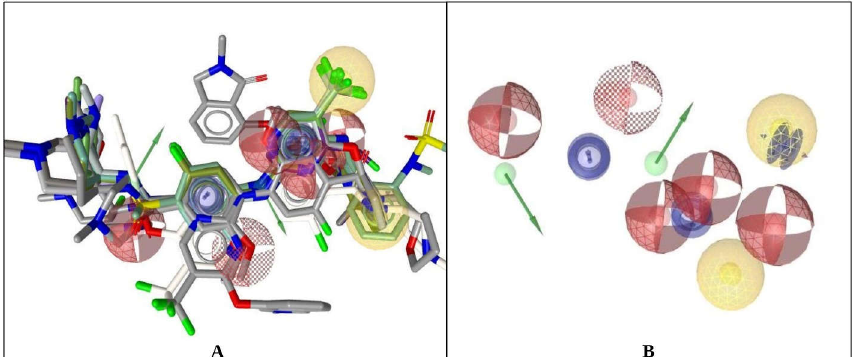
Figure 1. The 3D structure-based ligand-based model of FAK1 protein. ( A ) Ligand-based pharma- cophore features (Model 1) were generated after complex interaction. ( B ) Two yellow spherical shapes indicating hydrophobic interaction, one blue star shape depicting the positive ionizable with tolerance, five red colors spherical shapes indicating H bond acceptor, two hydrogen bond donors represented by green spherical, or arrow shape are identified within the protein–ligand complex interaction.